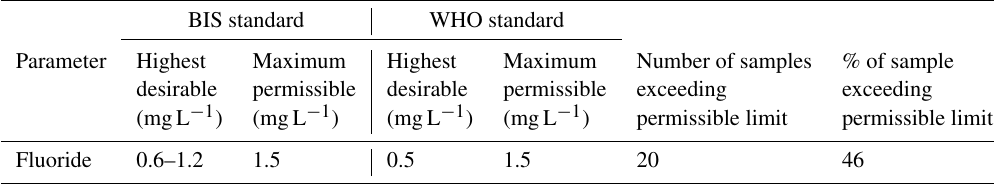
Table 2. Comparison of fluoride content with drinking water standards (BIS, 1991 and WHO,